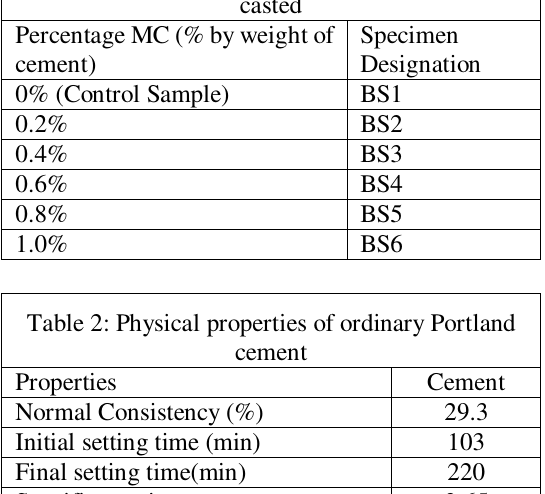
Table 1: Specimen type and number of samples